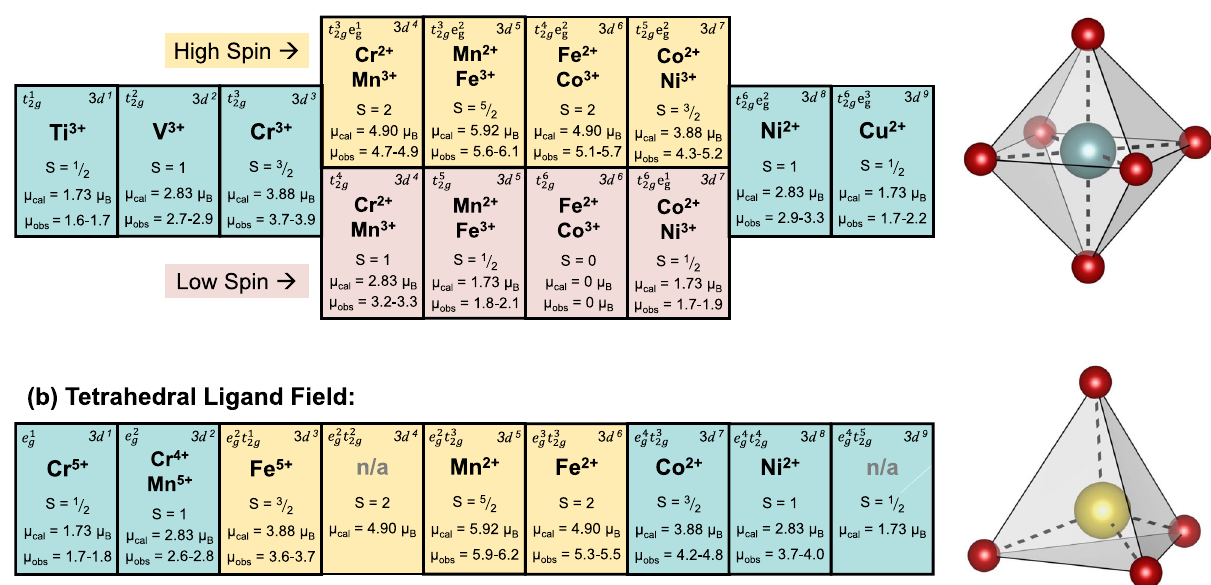
Fig. 6 Schematic illustration of the magnetic properties of 3 d transition metal ions. Magnetic properties of various 3 d transition metals in their common valence states in a octahedral and b tetrahedral ligand fi elds arranged according to their number of d electrons. Owing to quenching of orbital angular ffiffiffiffiffiffiffiffiffiffiffiffiffiffiffiffi p momentum, their calculated moments, μ cal ¼ g S ð S þ 1 Þ , are best estimated from the spin-only, S , value with an isotropic Landé g-factor, g = 2, giving good agreement with the observed moments, μ obs . In the octahedral case, the crystal fi eld ground state is formed by the three degenerate t 2g states with a crystal fi eld splitting to the two higher energy e g states, while the opposite pattern is observed for the tetrahedral case. When there are between four (3 d 4 ) or seven (3 d 7 ) electrons in the 3 d -orbitals, either high-spin (yellow) or low-spin (pink) states can be observed for the octahedral case, with the overall crystal fi eld splitting determining which is energetically preferred. The smaller crystal fi eld splitting in the tetrahedral case means that high-spin states are always obtained, with very few exceptions. Observed moments that exceed the calculated moment, such as for Co 2 + , imply an intermediate spin – orbit coupling and an incomplete quenching of orbital angular